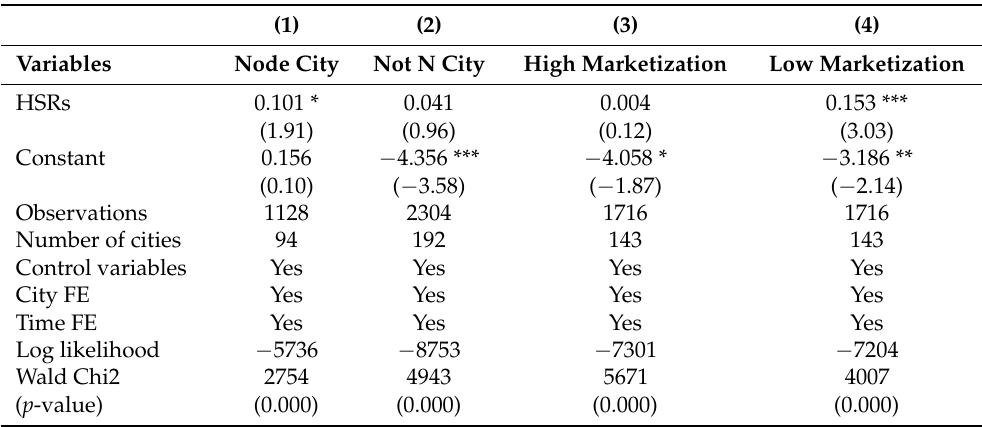
Table 4. Heterogeneity